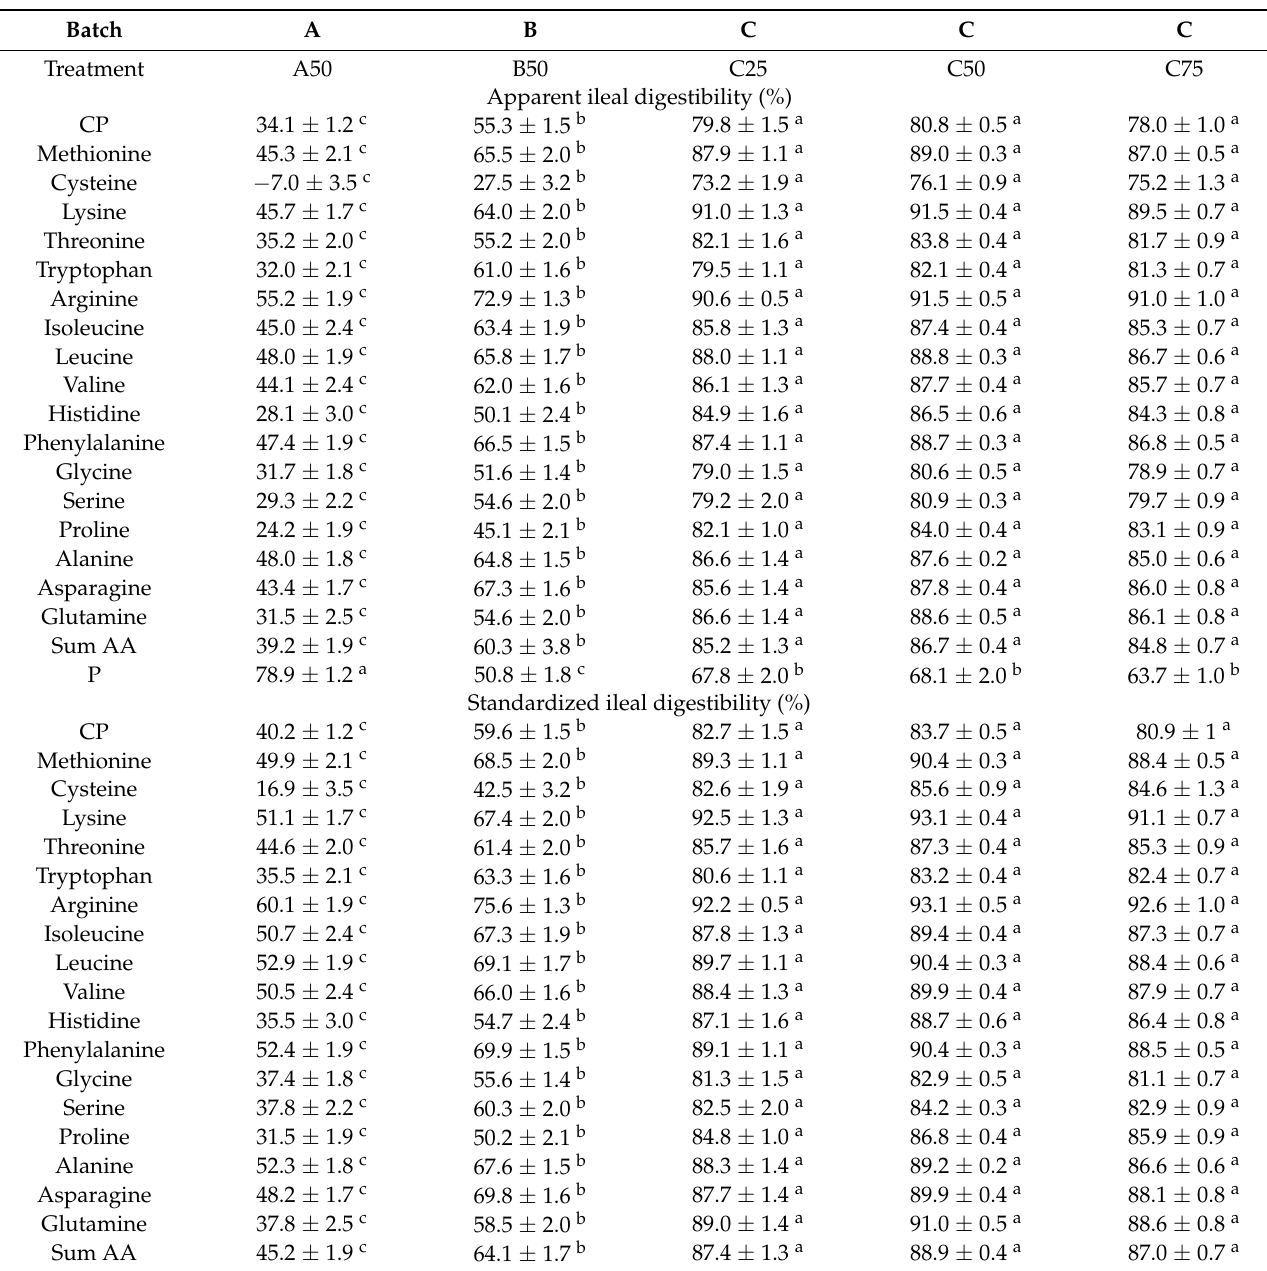
Table 4. Ileal digestibility of crude protein, amino acids and P of different duckweed